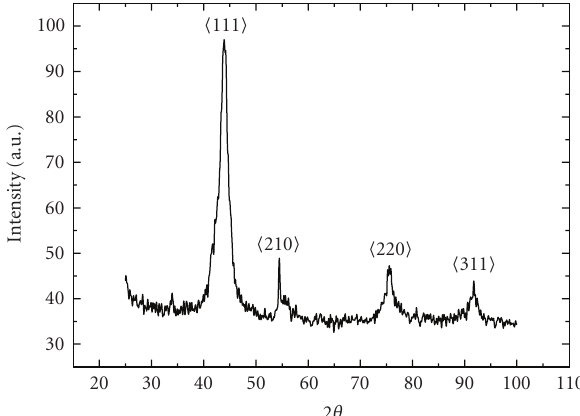
Figure 2: X-ray di ff raction spectrum of undoped NCD film grown on a silicon substrate.